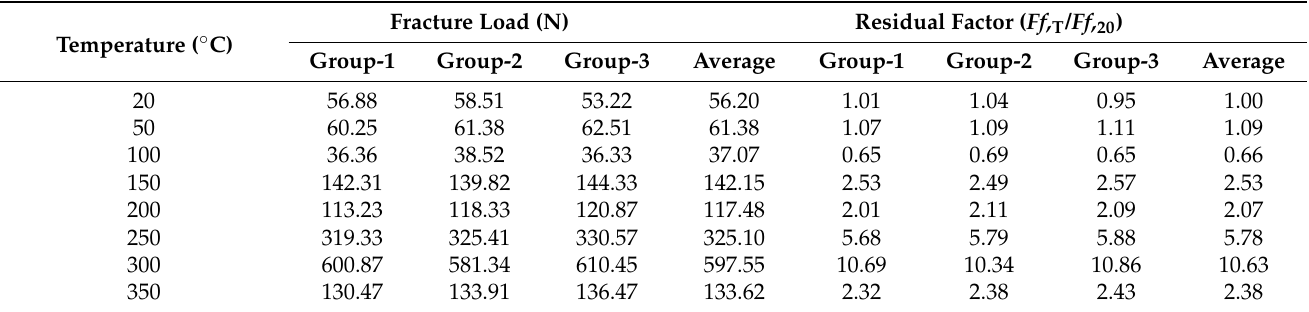
Table 3. Fracture loads and residual factors of the FRP composites at elevated temperatures.